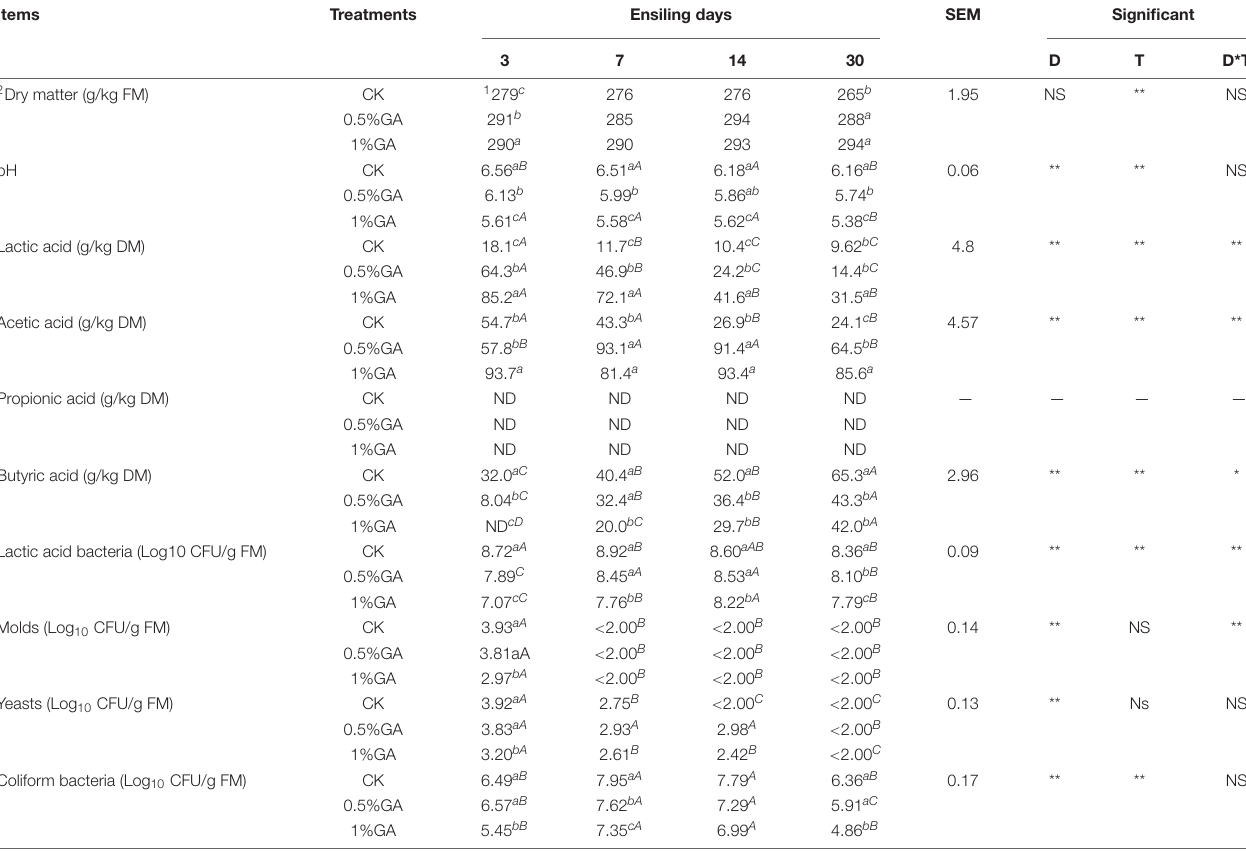
TABLE 2 | Organic acid contents, pH and microbial population of ensiled whole plant soybean. Items